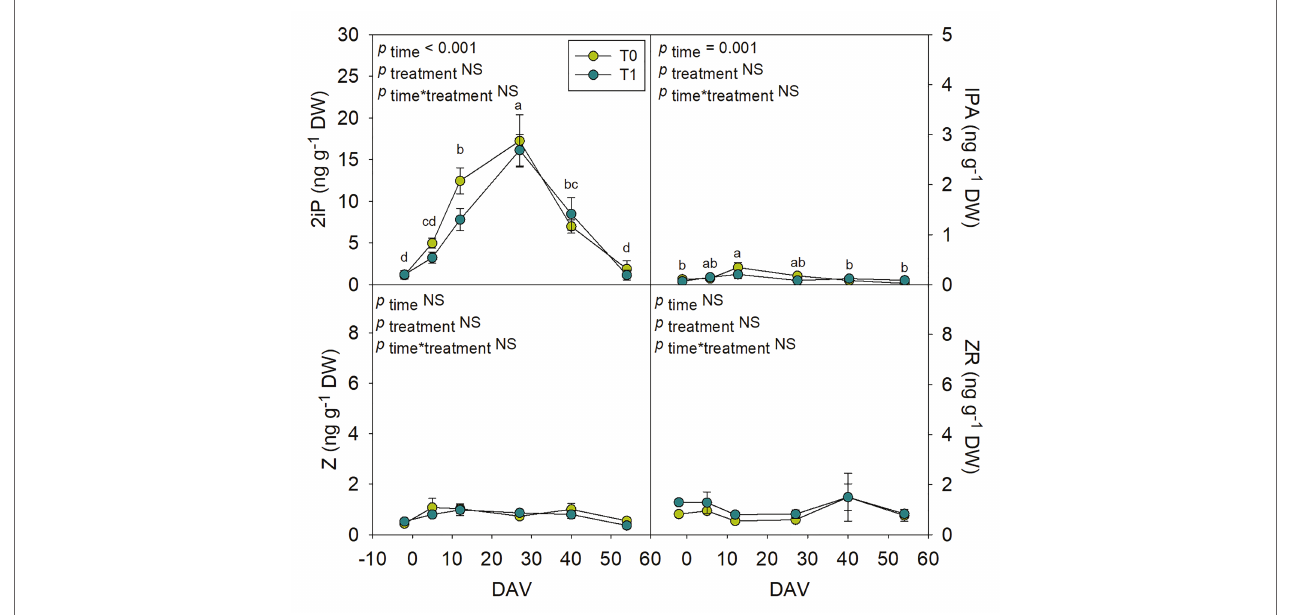
FIGURE 4 | Endogenous variations in cytokinins in whole berries of “Merlot” grapes during ripening in non-irrigated (T0) and irrigated (T1) vineyards. 2-isopentenyl adenine (2iP), isopentenyl adenosine (IPA), trans -zeatin (Z), and trans -zeatin riboside (ZR) contents in grapes throughout ripening are shown. Vertical bars indicate SE of six replicates. Different letters denote significant differences among sampling dates (Tukey’s HSD post-hoc test p < 0.05). No significant differences between treatments were observed ( p >